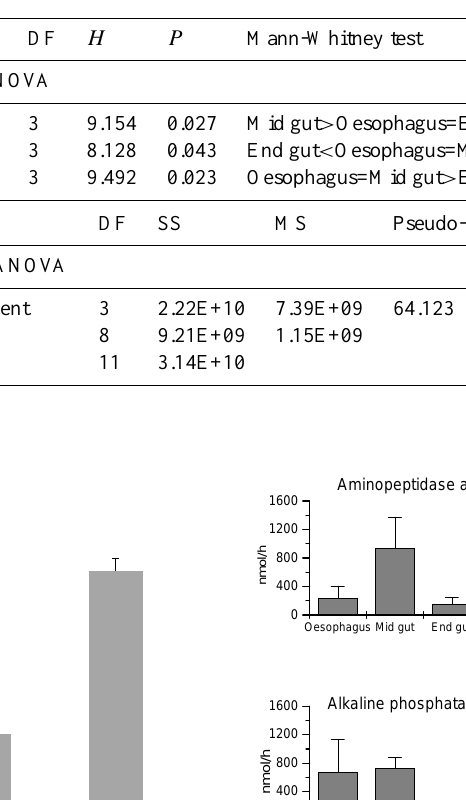
Table 4. Results of the Kruskal-Wallis ANOVA (a) and PERMANOVA (b) tests carried out to ascertain differences in extracellular enzymatic activities among the various sections of the holothurians’ gut (ANOVA and SNK tests) and between the gut and the sediment. DF = degrees of freedom, SS = sum of squares; MS = mean square; F = F statistic; P = probability level; ** = P < 0 . 01; ns = not significant; na = not applicable.